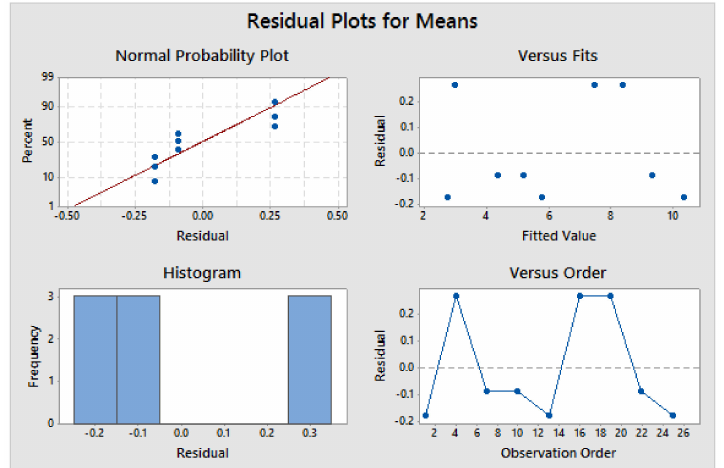
Figure 10. Residual plots for means.